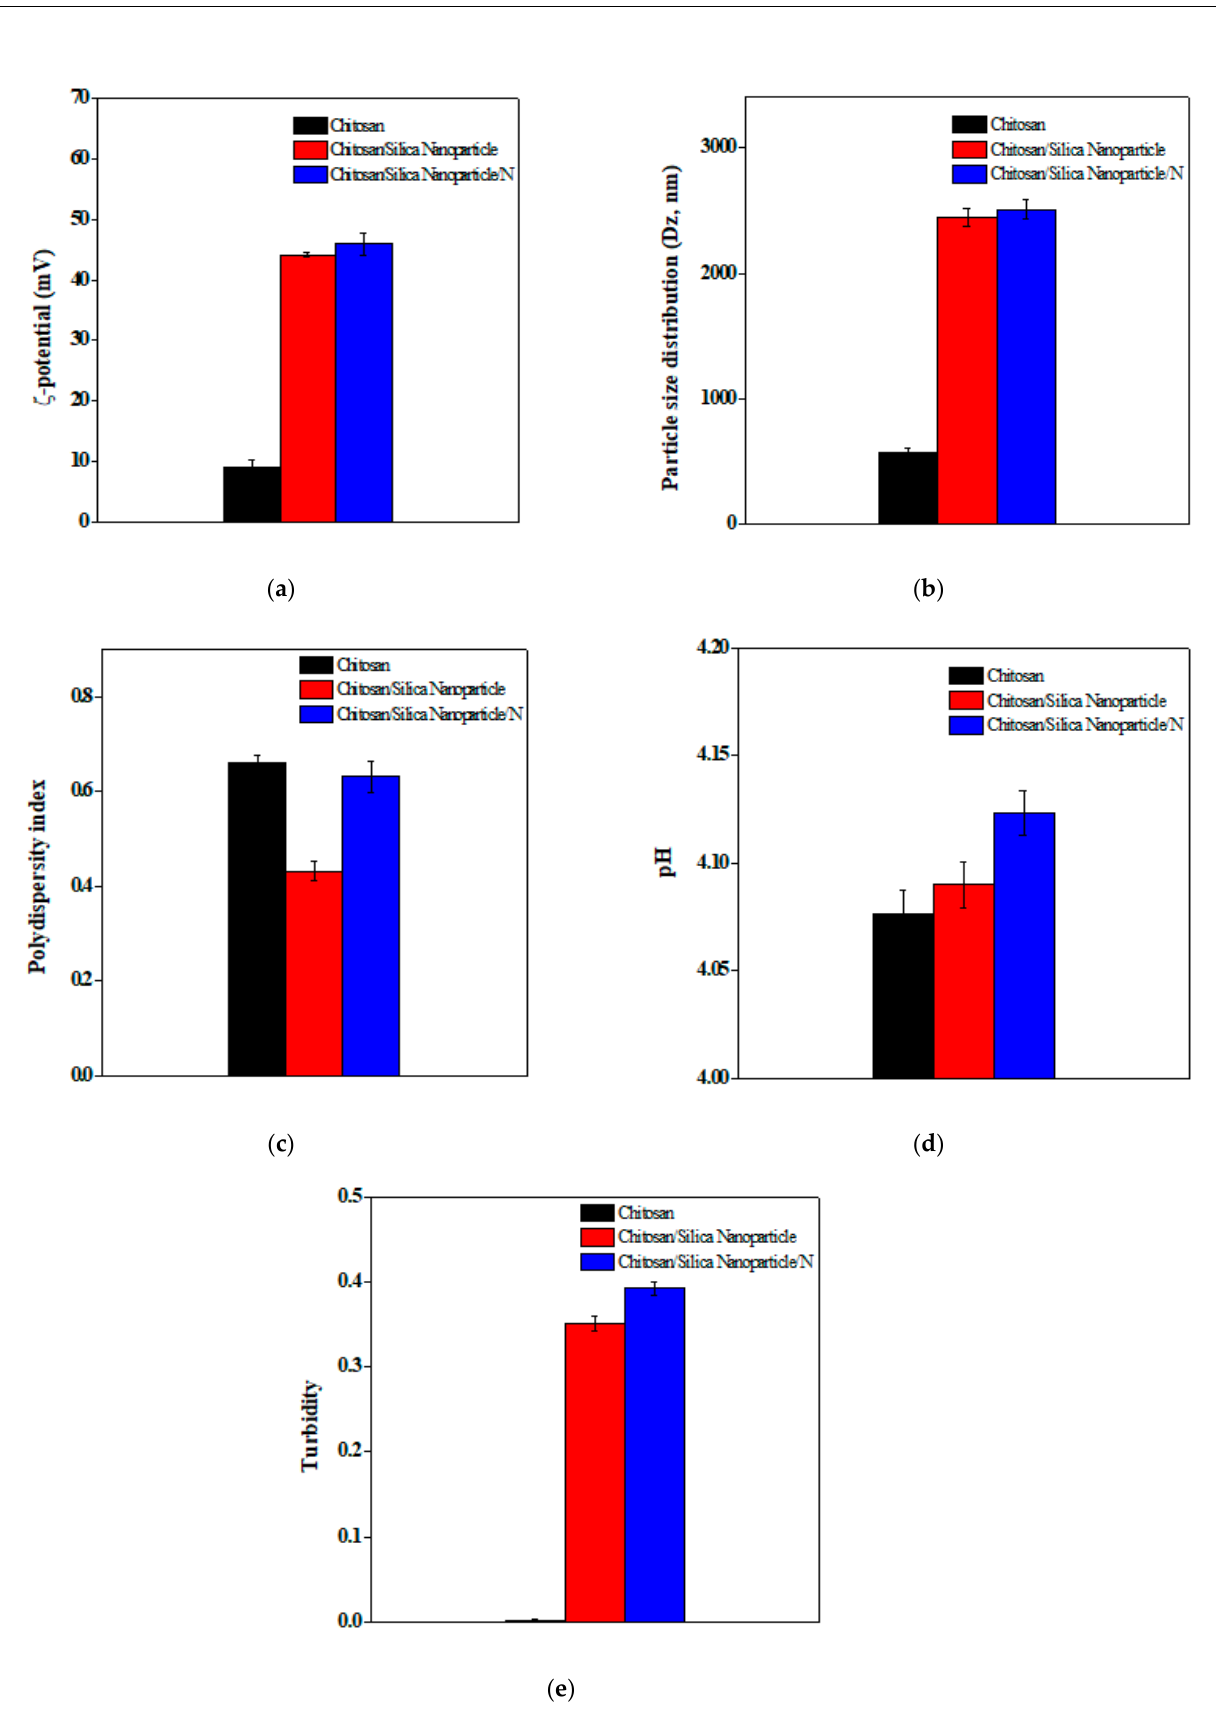
Figure 5. Some physical–chemical characteristics; ζ -potential ( a ), particle size distribution ( b ), polydispersity index ( c ), acidity ( d ), and turbidity ( e ) of the novel films.